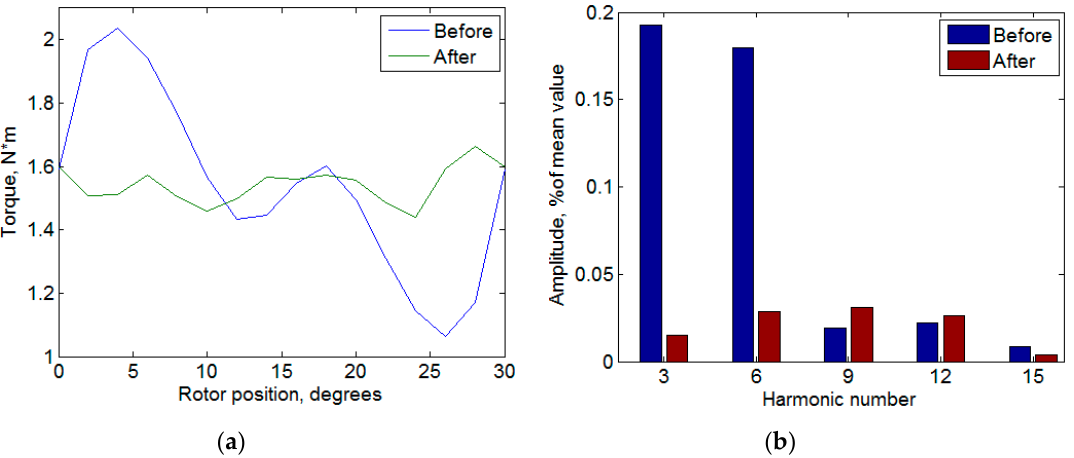
Figure 10. ( a ) The three-phase FRMs’ torque ripple; ( b ) its Fourier spectrum.